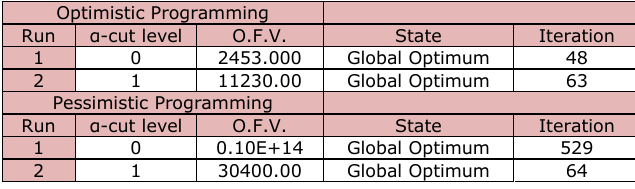
Table 5. “Objective Function